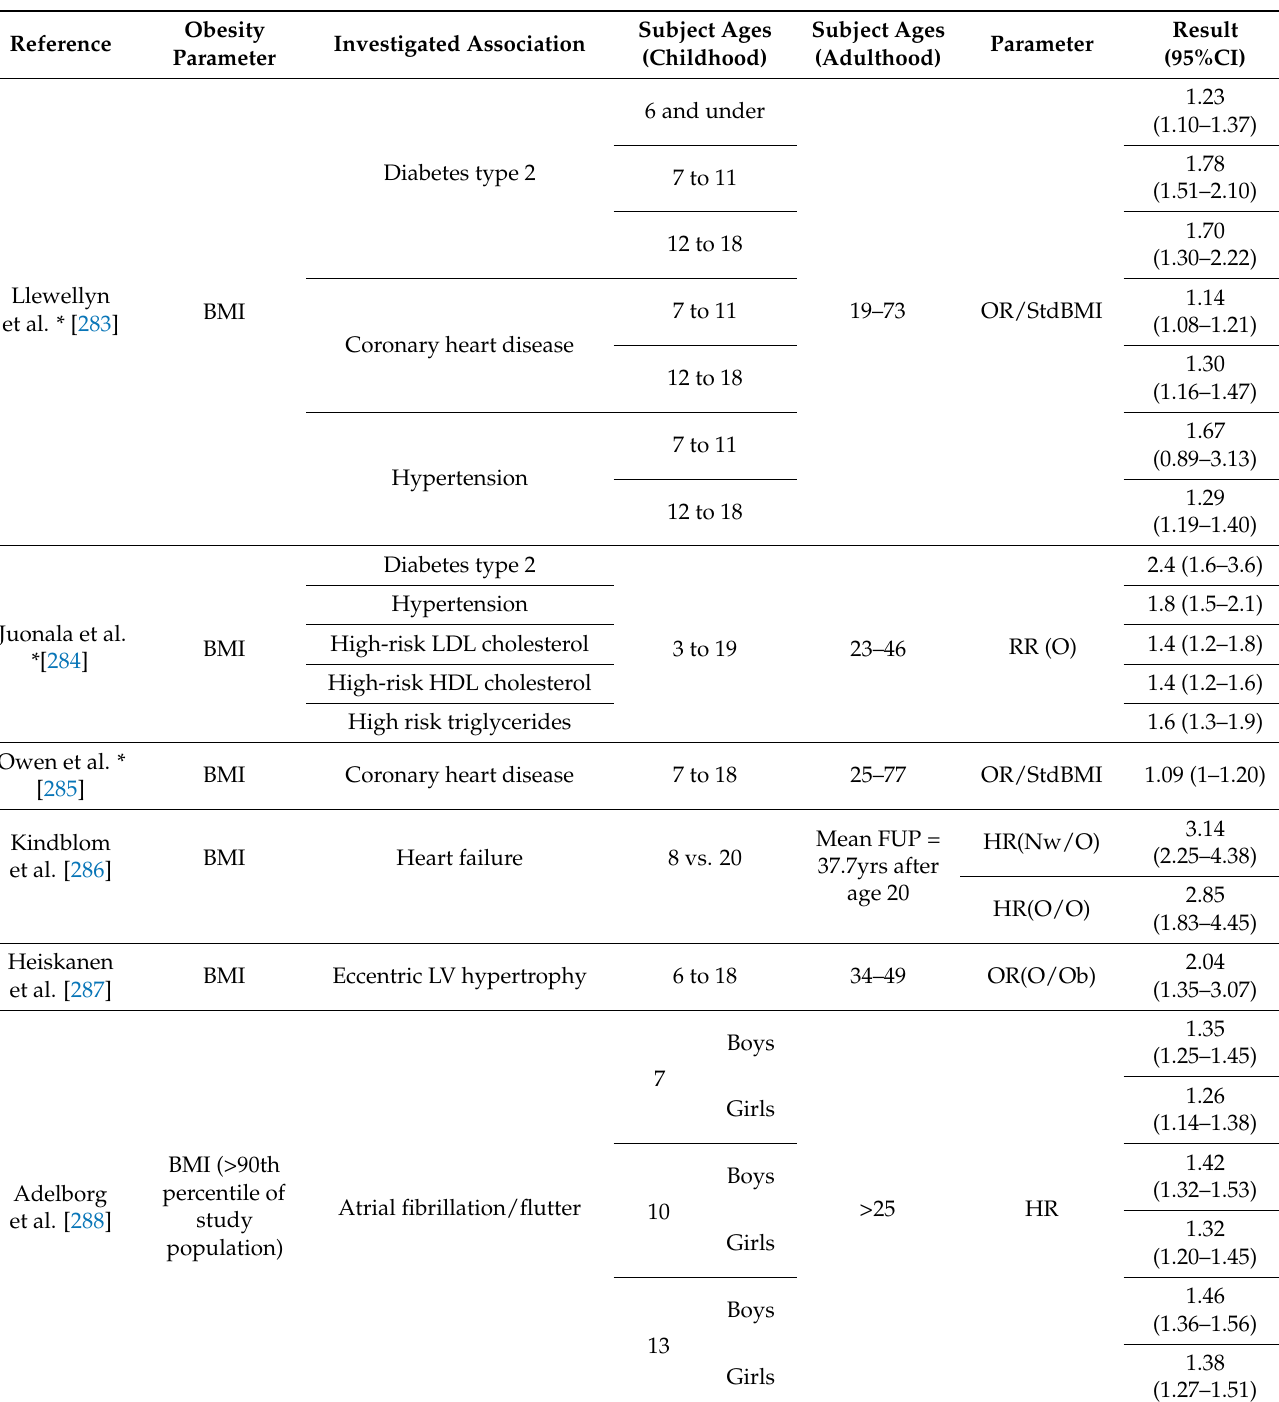
Table 4. Observational evidence showing childhood obesity leading to adult